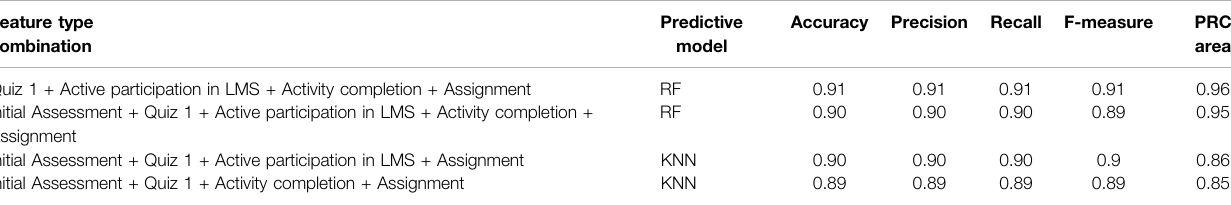
TABLE 5 | Feature types of a combination comparison for performance prediction of students ’ third module